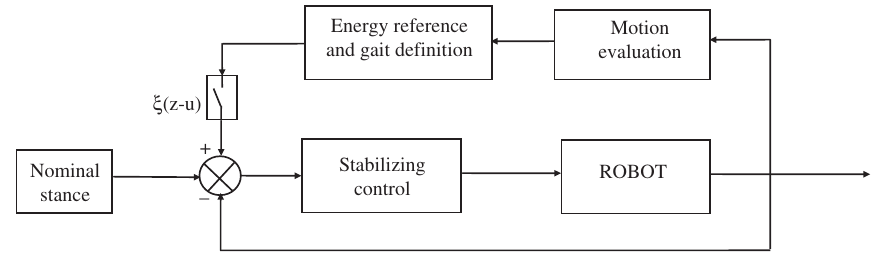
Figure 4: Gait stabilization and energy